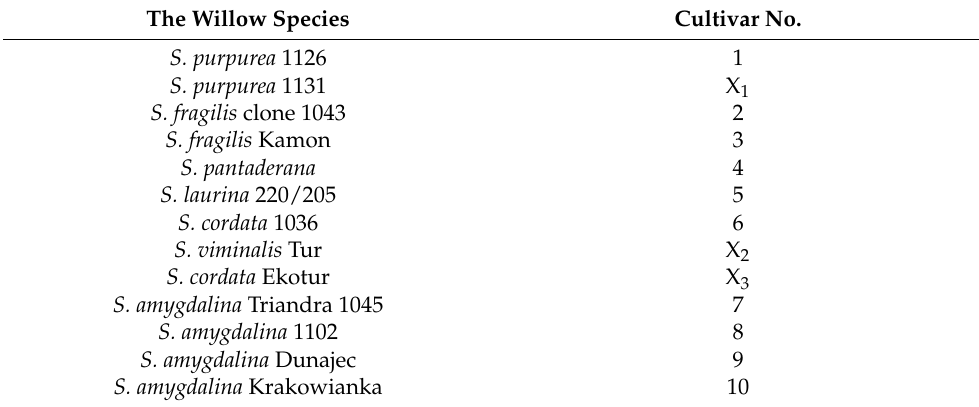
Table 1. The cultivar numbers used later in the work in the tables and figures. The Willow Species Cultivar